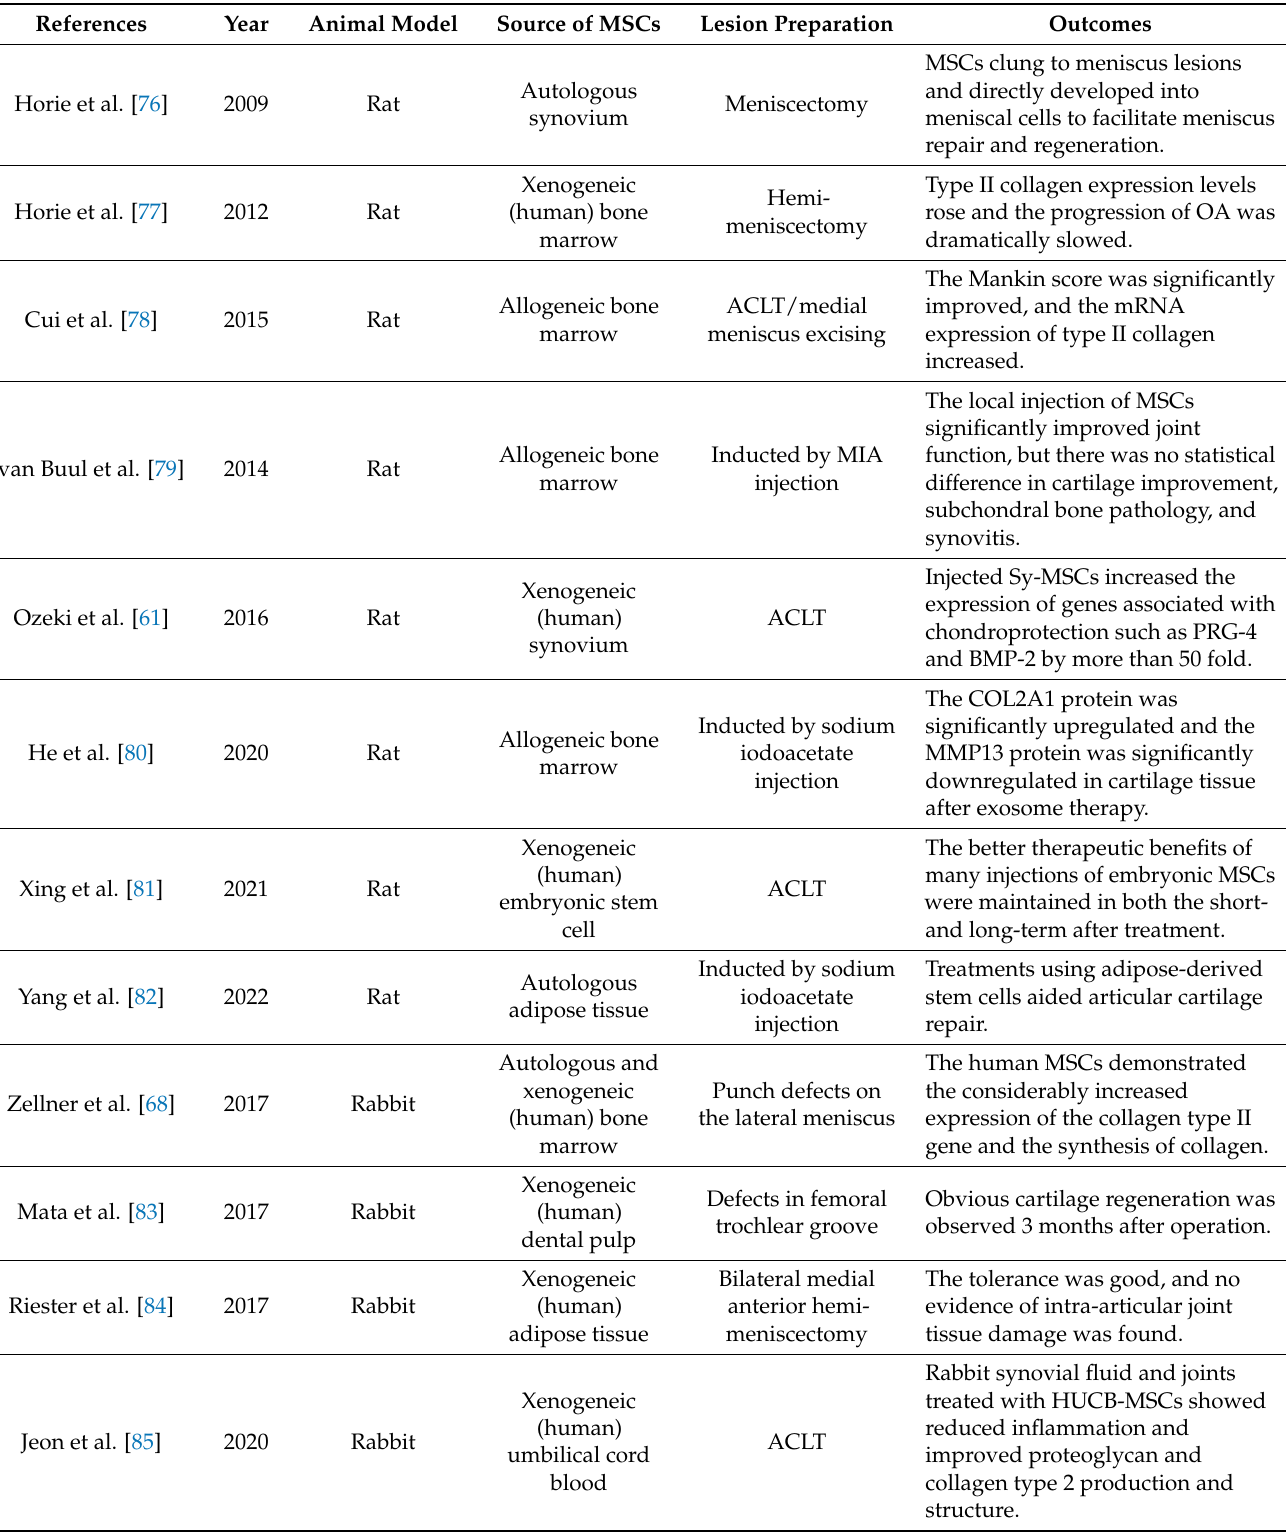
Table 1. Overview of preclinical studies applying different sources of MSCs for OA